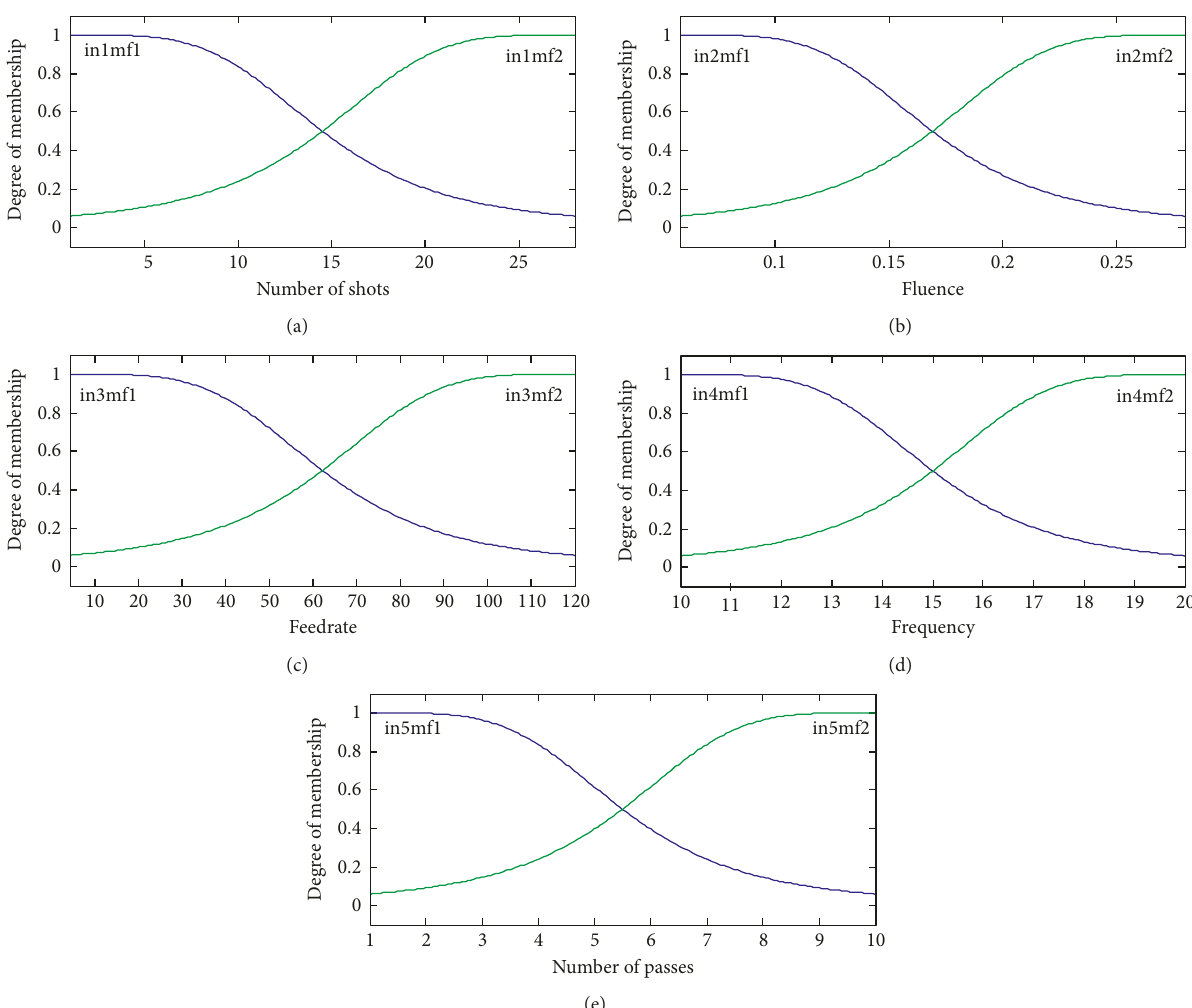
Figure 7: Membership function diagrams based on generalized bell for all inputs: (a) number of shots, (b) fluence, (c) scanning speed, (d) pulse repetition rate, and (e) number of